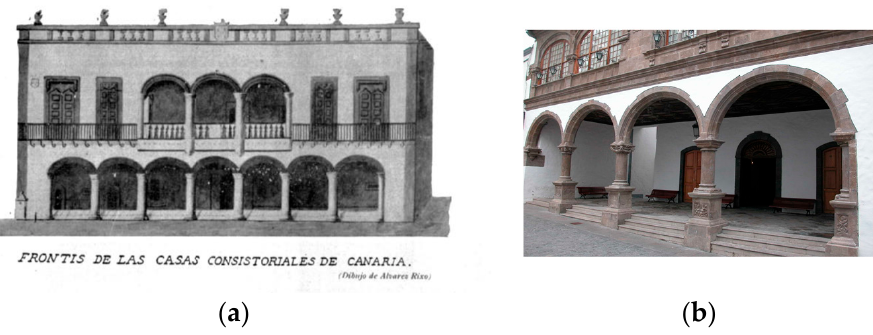
Figure 15. Drawings and photographs used in the 3D reconstruction of the Cabildo House: ( a ) Las Palmas de Gran Canaria Town Hall and ( b ) Santa Cruz de La Palma Town Hall.